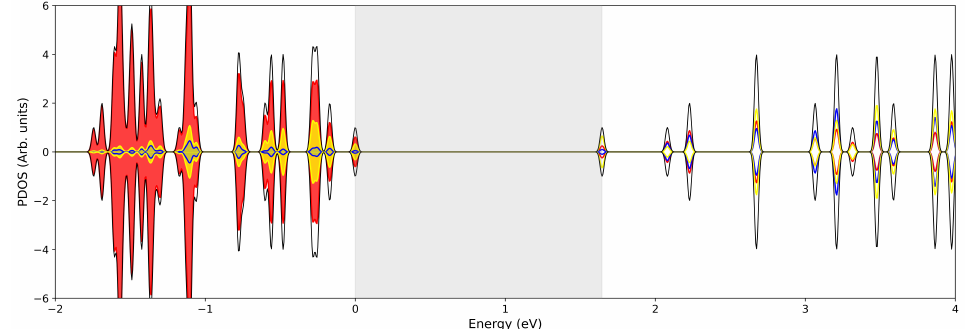
Figure 2. PDOS of CuAlS 2 (copper = red, sulfur = yellow, aluminium =